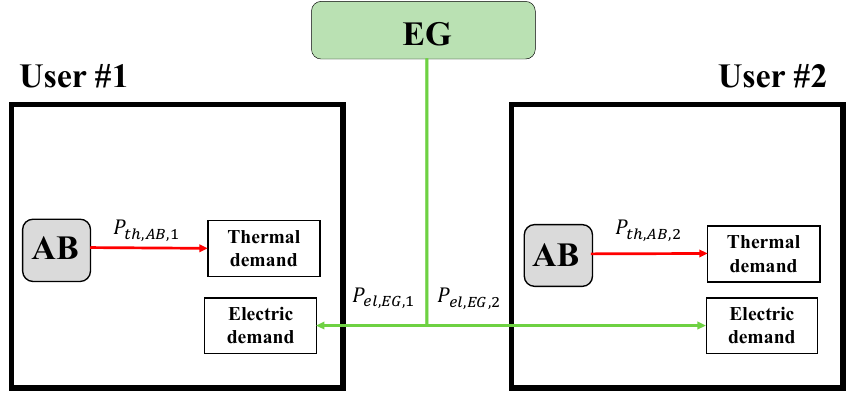
Figure 1. Reference scenario.